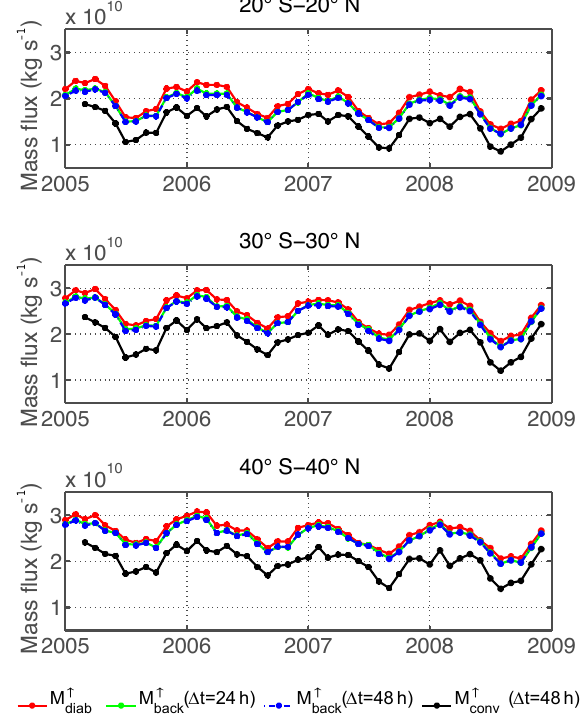
Figure 11. Uncorrected upward diabatic mass flux on the 380K ↑ surface. M (red) versus the Lagrangian diabatic mass flux M ↑ diab and diab on the same surface calculated with delays (cid:49)t = 24h (green) and (cid:49)t = 48h (blue). The black curve shows M ↑ of M with (cid:49)t = 48h that originates from backward trajectories ↑ back : kinematic kine encountering a cloud within the previous 3